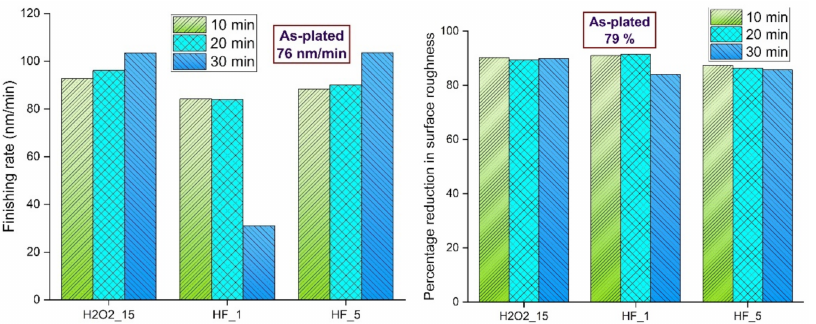
Figure 15. Finishing rate and percentage reduction in areal surface roughness of as-plated and chemically treated surfaces.